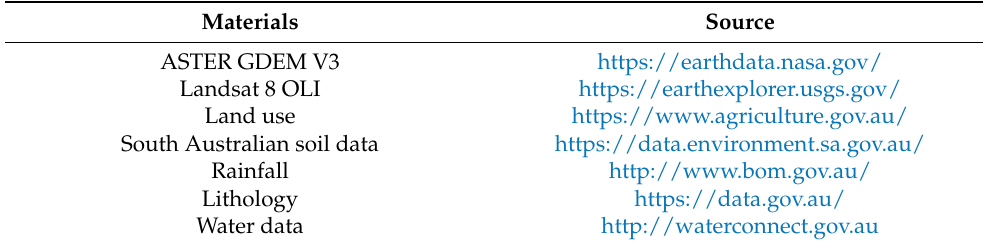
Table 1. Sources of remote sensing and secondary data.